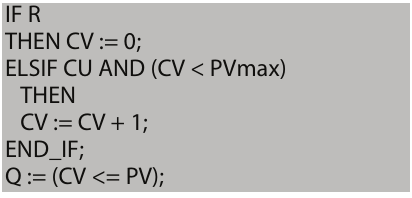
Figure 2: FB body of the up-counter FB in ST